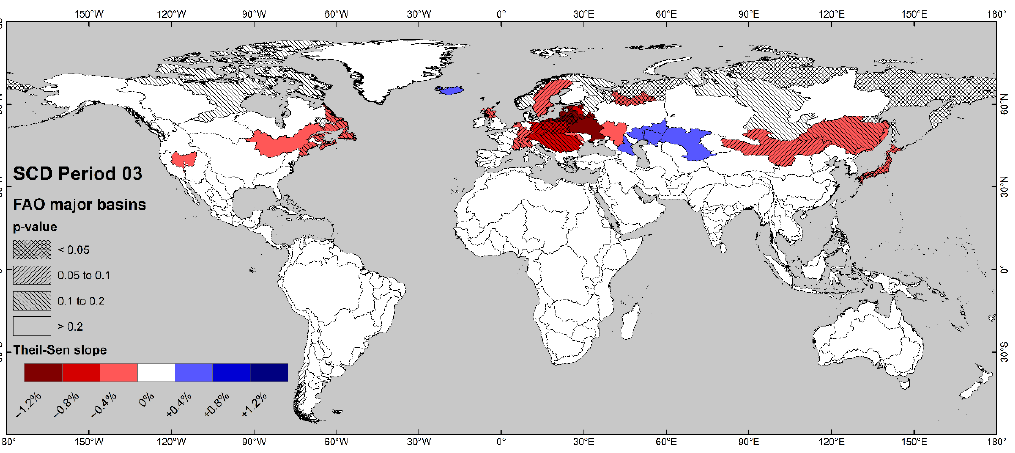
Figure 13. Basin-based development of the SCD in March. The Theil – Sen slope is color coded and the corresponding p -values are hatched over it.